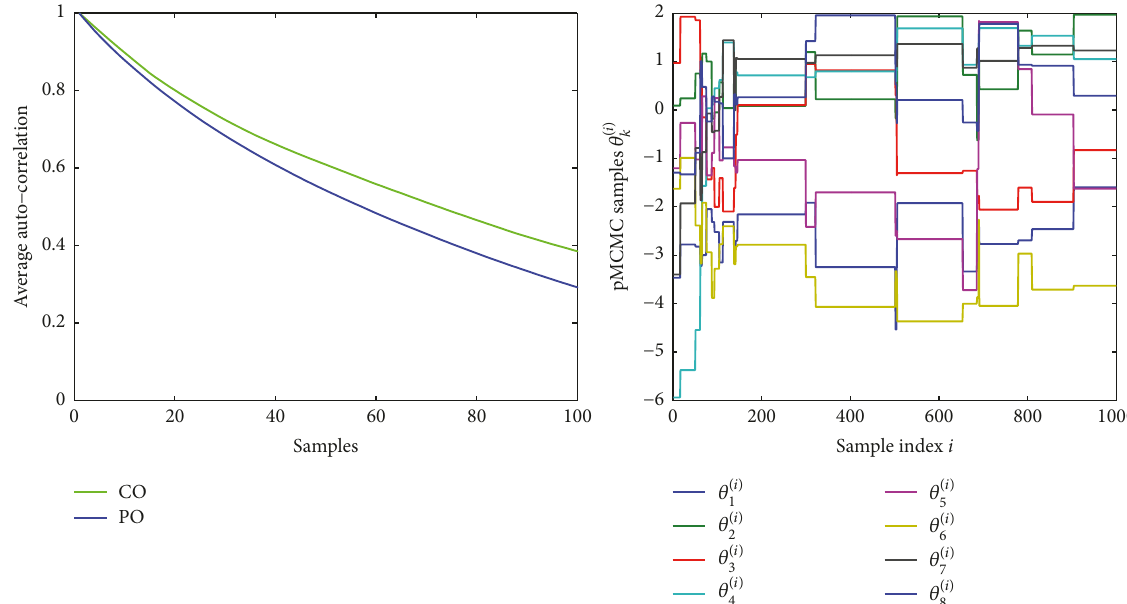
Figure 7: Left . Autocorrelations based on the final sample of size 10 3 of the pMCMC scheme in the CO and the PO scenarios, averaged over 𝑃 = 100 simulation runs. Right . Markov chain provided by the pMCMC method in the PO scenario, corresponding to the average simulation run depicted with a big square in Figure 5 ( left ).